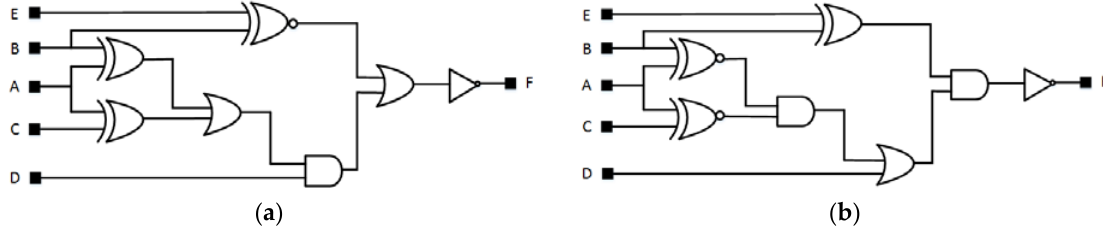
Figure 48. A digital logic gate schematic ( a ) original design; ( b ) after polymorphic gate